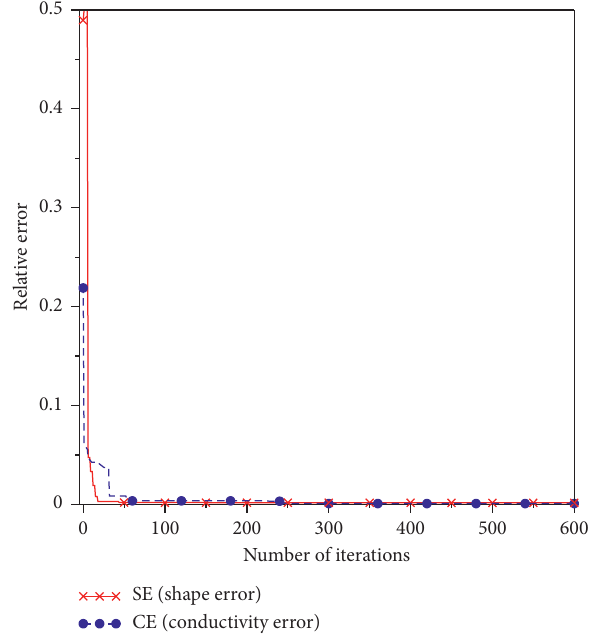
Figure 9: The fitness value with respect to iteration loops of the whale optimization algorithm for the second example.